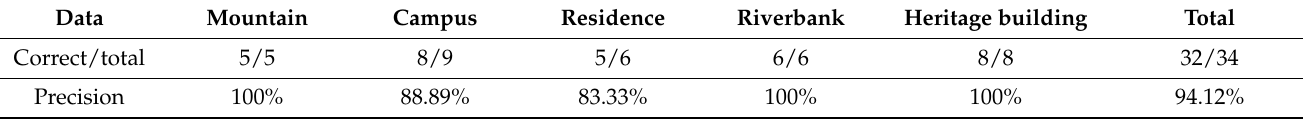
Table 7. Pairwise rough registration results using the proposed PPTFH descriptor on the WHU-TLS datasets.